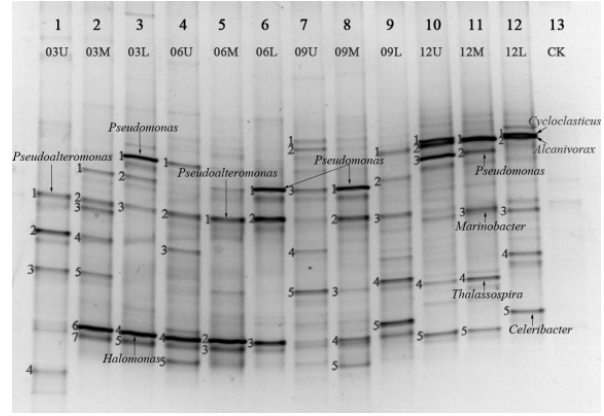
Figure 5. PCR-DGGE profiles of 12 PAH-degrading consortia that were enriched at 25 ◦ C. Lanes 1–3, site BN03; lanes 4–6, site BN06; lanes 7–9, site BN09; lanes 10–12, BN12; and lane 13, negative